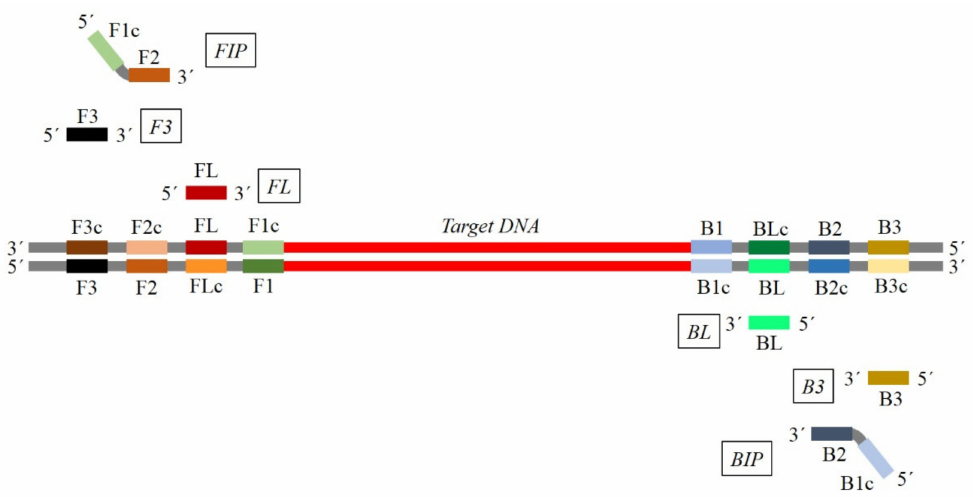
Figure 1. Typical map for loop mediated isothermal amplification (LAMP) primer set positioning and corresponding sequence homology. For each primer, the same color represents the corresponding sequence in the target. The primer sequence corresponds to the reverse complementary sequence of the target region. (FIP: forward inner primer; F3: forward outer primer; FL: loop primer F-Loop; BL: loop primer B-Loop; B3: backward outer primer; BIP: backward inner